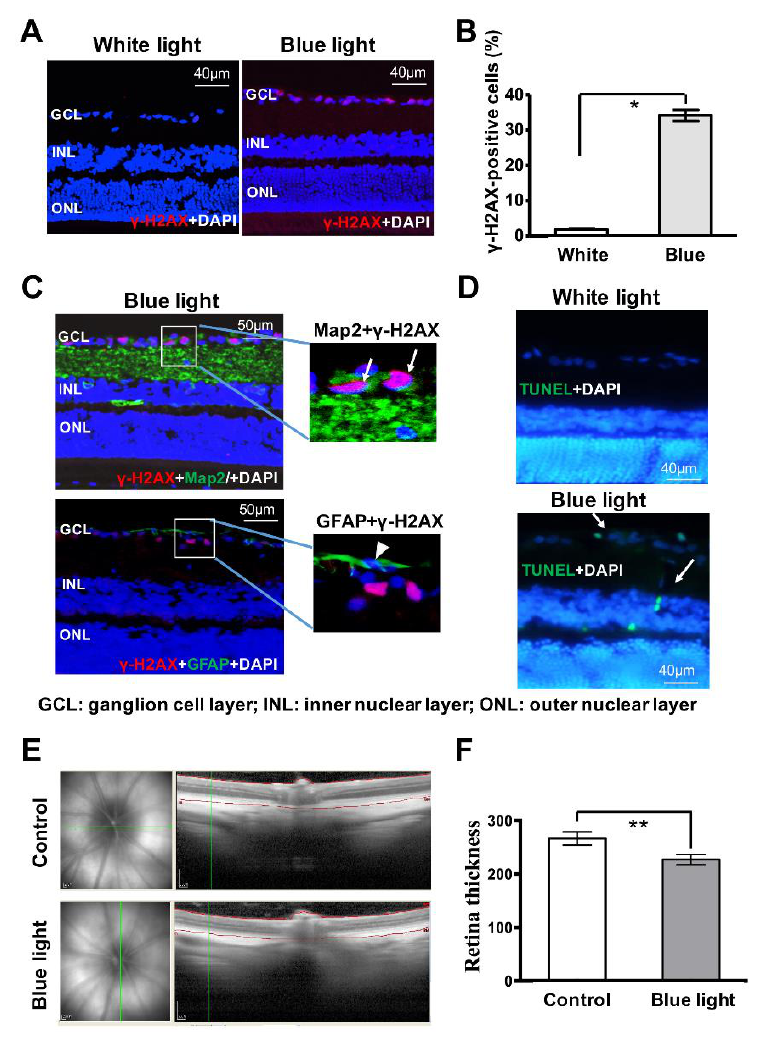
Figure 6. Short term blue light induces DNA damage in retinal neurocytes in vivo . ( A ) γ -H2AX (red) staining demonstrates that blue light induces significant DNA double-strand breaks (DSBs) in GCL of rat retina compared with that of white light. ( B ) The γ -H2AX positive retinal neurocytes cell numbers were presented as a histogram. ( C ) Double staining assay of Map2 (green) or GFAP (green) and γ -H2AX (red) indicates that 2 h of blue light exposure induces γ -H2AX foci formation in Map2-positive cells in rat retina. ( D ) Blue light exposure induced apoptosis in rat retina. ( E ) Histogram representing the significant difference of retina thickness of rat with or without blue light exposure for a month. ( F ) One month of blue light exposure induced retina thinness in the rat model, as evidenced by SD-OCT. (GCL: ganglion cell layer; INL: inner nuclear layer; ONL: outer nuclear layer). Error bars represent mean ± SD. Asterisks indicate statistically significant differences between control and experimental samples (* p < 0.05, ** p < 0.01).